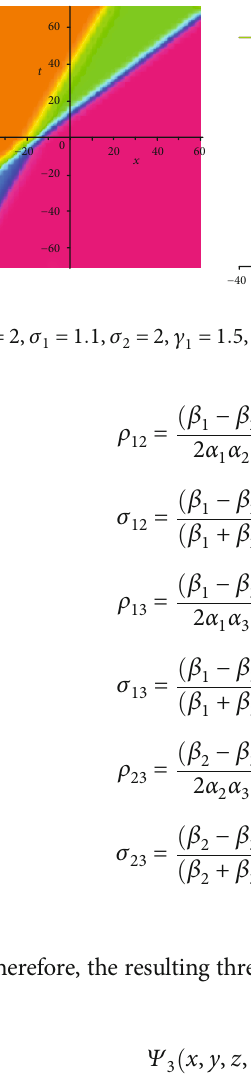
= 1, β = 1 : 5, σ = 1 : 5, ρ = 2 : 2, γ = 2, ρ = 3, y = 10, and z = 2 1 2 1 1 1 2